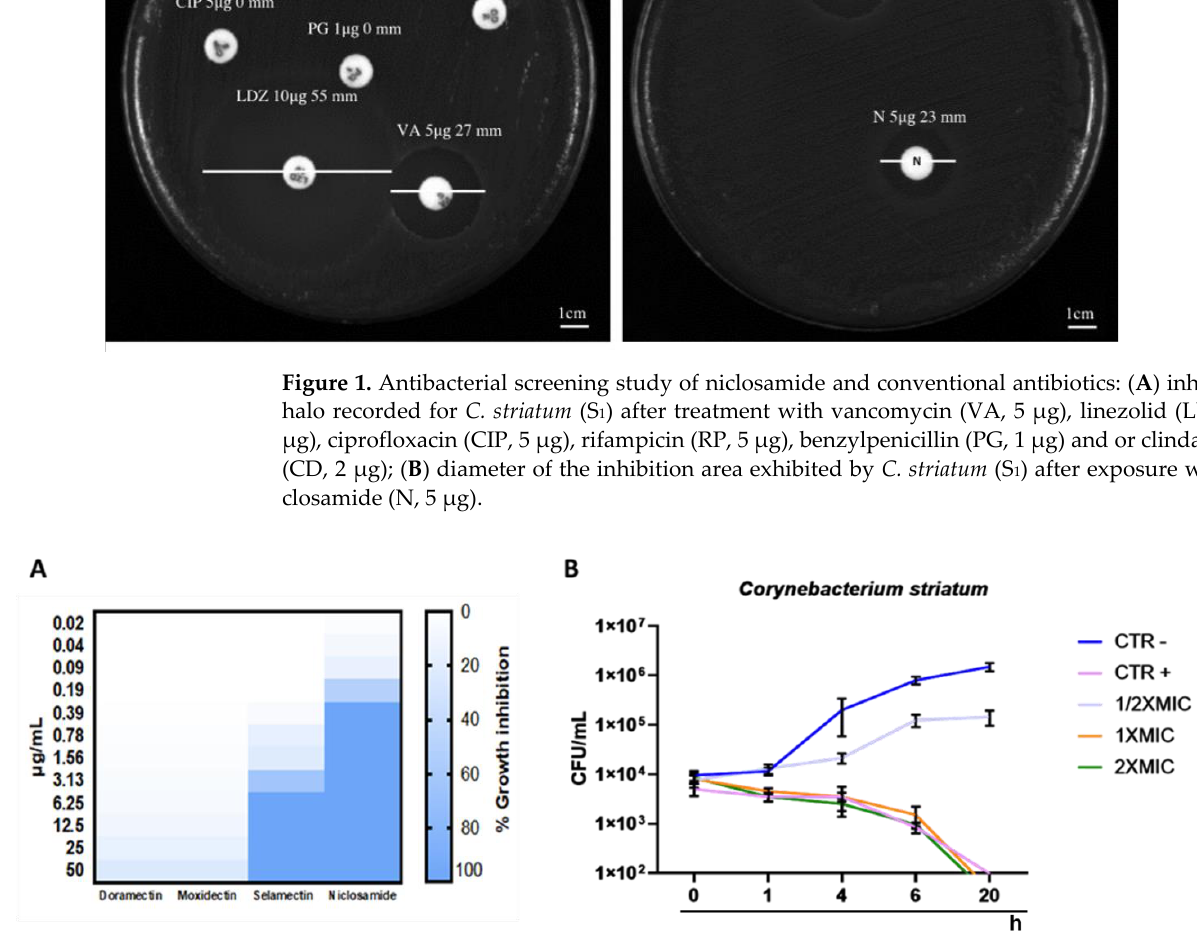
Figure 2. Antibacterial potential of anthelmintic drugs: ( A ) heatmap representation of bacterial in- hibition after treatment of C. striatum S 1 with doramectin, moxidectin, selamectin and niclosamide for 20 h; ( B ) time-kill kinetics of niclosamide against C. striatum cells. Negative control (CTRL-): untreated cells; CTRL+: bacteria treated with vancomycin (5 μg/mL); The data represent the mean ± standard deviation